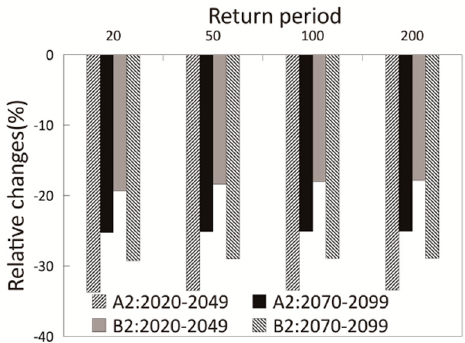
Figure 15. Changes in the encounter probabilities of drought with the same frequency in comparison with the reference period.